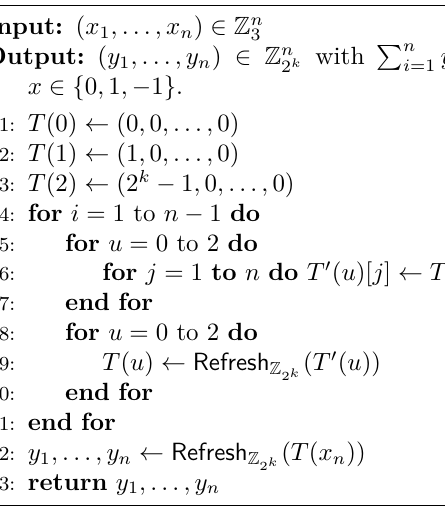
( x 1 , . . . , x n ) 3 , Z 2 k